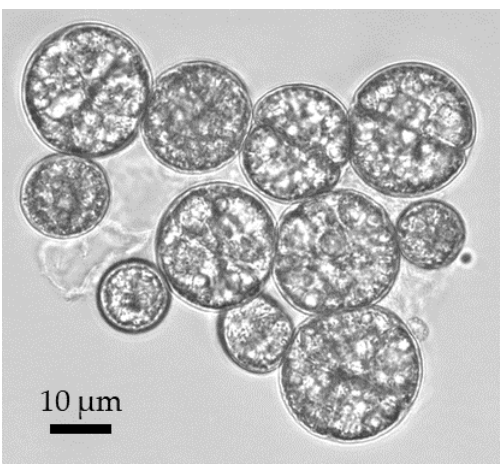
Figure 3. Light microscopic images of the microalga Crypthecodinium cohnii.